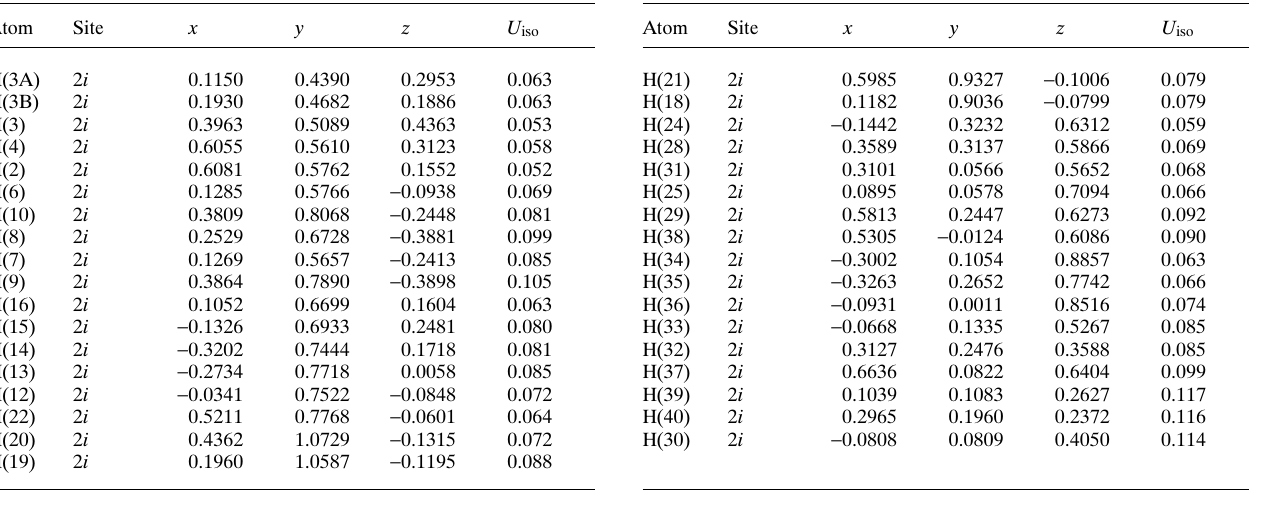
Table 2. Atomic coordinates and displacement parameters (in Å2)